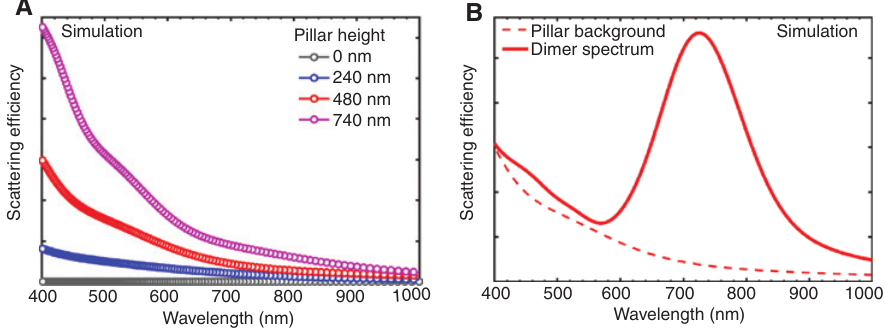
Figure 4: Effect of nanopillar height on scattering spectra. (A) Simulated scattering spectra of 150 nm diameter nanopillar dimers with a 30 nm gap without Au nanoantennas on top. A tail clearly forms at lower wavelengths, which increases with increasing pillar height. (B) Plot of the 480 nm diameter spectrum with and without nano- antennas, showing that the tail is present in both